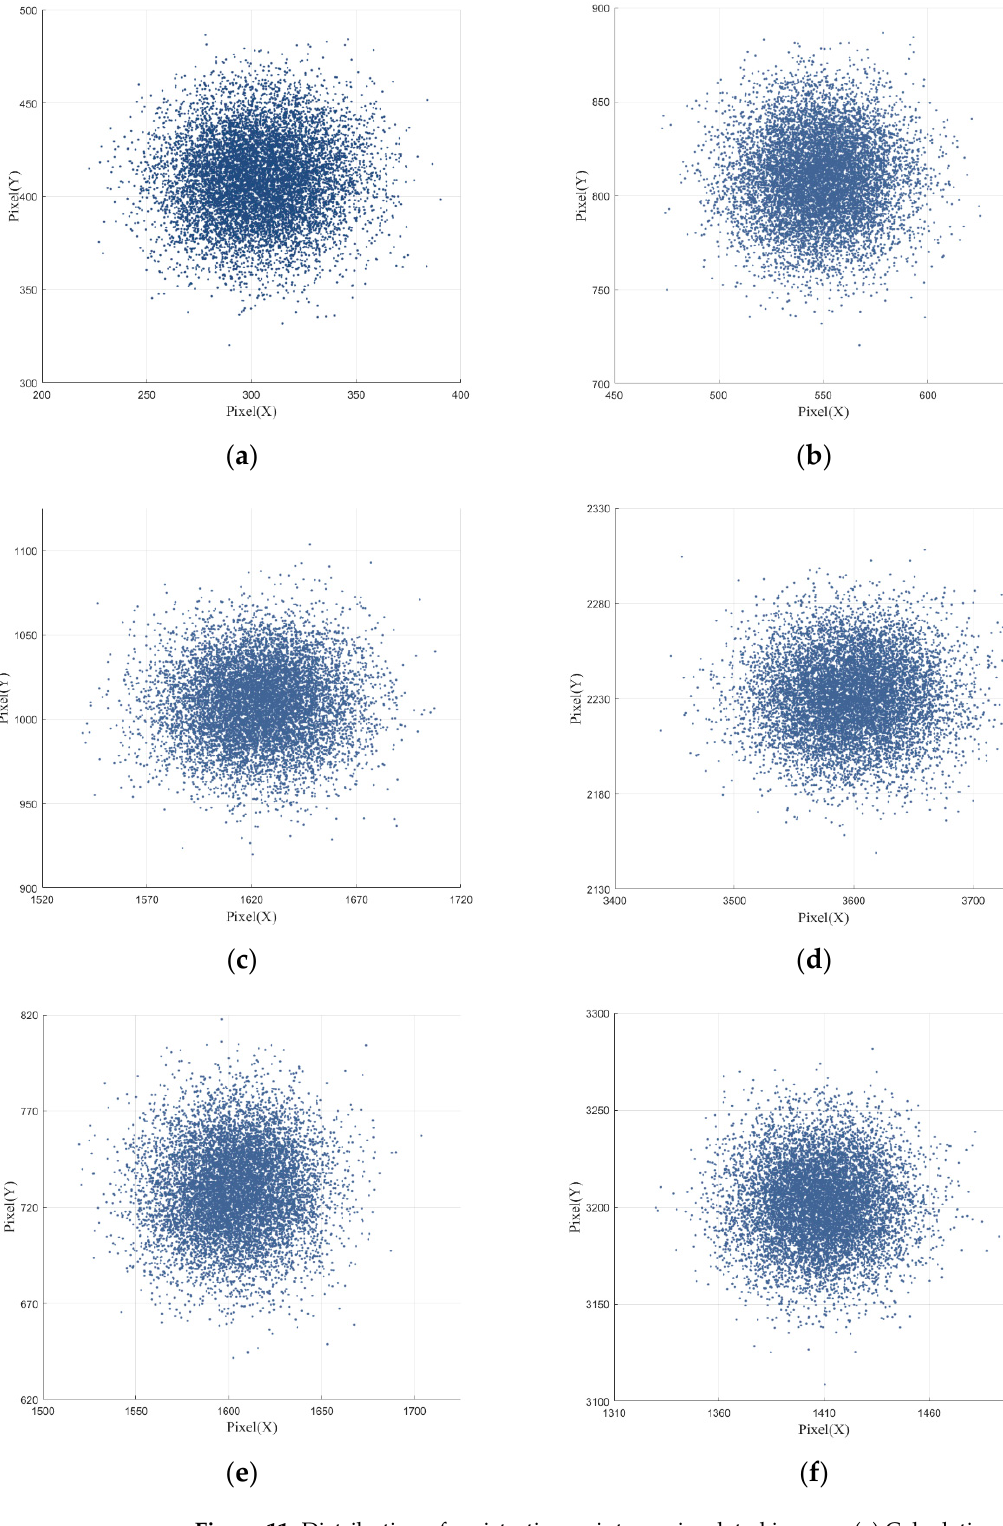
Figure 11. Distribution of registration points on simulated images. ( a ) Calculation results of registration point 1 in aerial remote sensing image; ( b ) calculation results of registration point 1 in satellite remote sensing image; ( c ) calculation results of registration point 2 in aerial remote sensing image; ( d ) calculation results of registration point 2 in satellite remote sensing image; ( e ) calculation results of registration point 3 in aerial remote sensing image; ( f ) calculation results of registration point 3 in satellite remote sensing image.